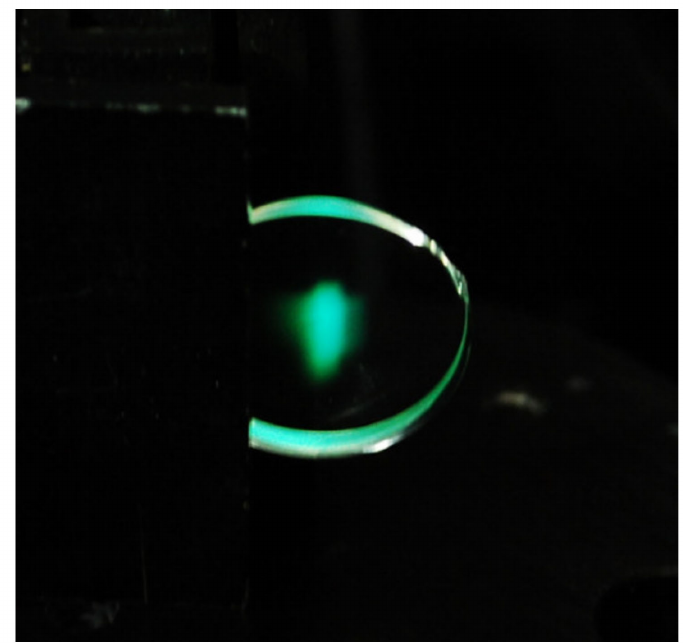
Figure 15. Photo of Tb2,6DClB/PMMA in the measuring